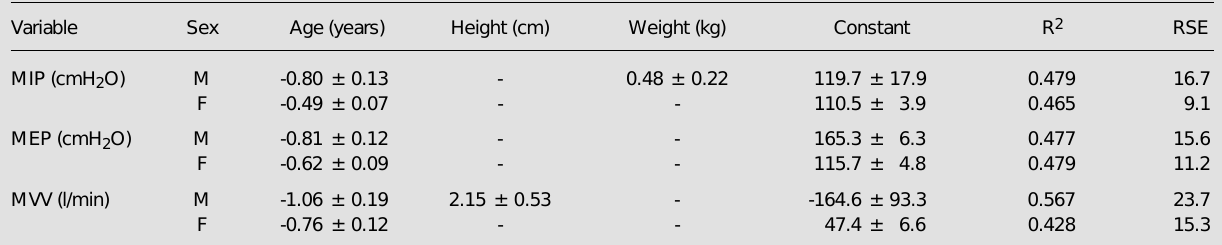
Table 3 - Linear prediction equations for maximal inspiratory pressure (MIP), expiratory pressure (MEP) and voluntary ventilation (MVV) in males (M) and females (F) aged 20 to 80. Values in the columns represent coefficient estimates followed by the respective standard error of the estimate. R 2 = Coefficient of determination; RSE = residual standard